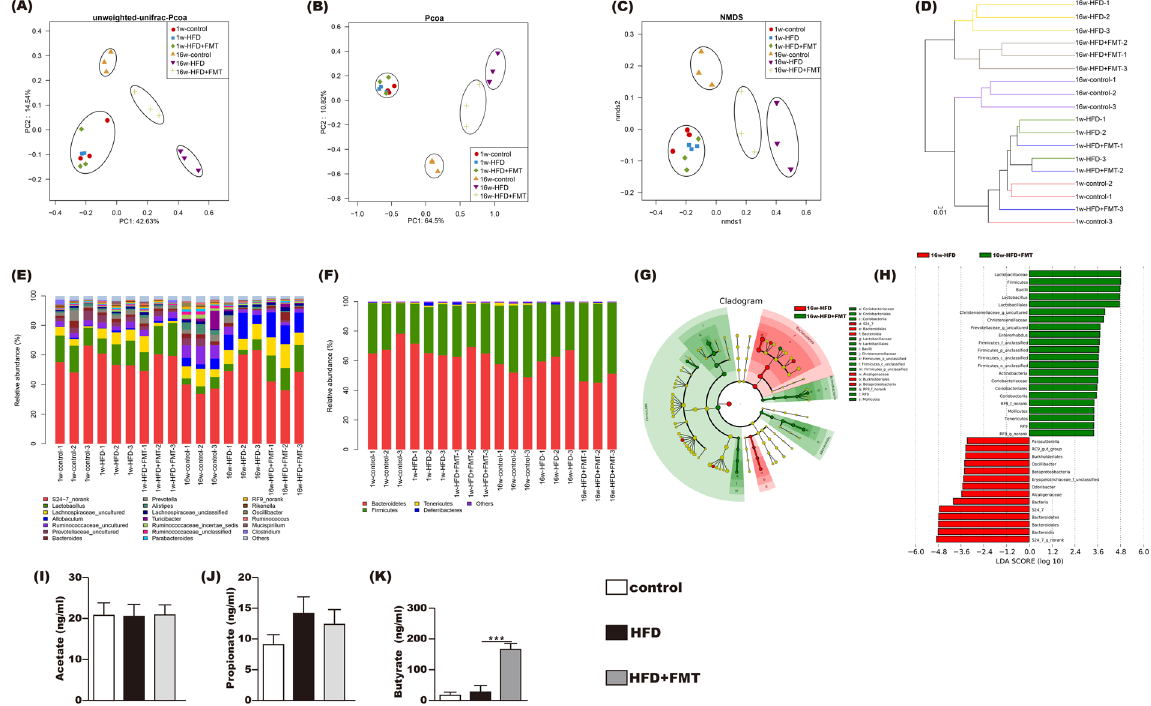
Figure 2. Influences of FMT on gut microbiota. ( A,B ) Scatter plot of the unweighted-unifrac-principal co- ordinates analysis (PCOA) score showing the similarity of the 18 bacterial communities based on the Unifrac distance and Scatter plot of the weighted-PCOA score. ( C ) Nonmetric multidimensional scaling (NMDS) showing the difference in bacterial communities according to the Bray-Curtis distance. (D) Hierarchical cluster analysis. ( E,F ) Bacterial composition of the different communities at the genus level ( E ) and at phylum level ( F ). Sequences that could not be classified into any known group were assigned as “no rank.” ( G,H ) Differences were represented in the color of the most abundant group. Key phylotypes of the gut microbiota responding to FMT treatment ( G ), the histogram ( H ) showing the lineages with LDA values as determined by LEfSe. ( I,K ) The acetic acid, propanoic acid and butyrate acid levels of the cecal content. The data represent the mean ± S.E.M. (n = 12 mice per group), *** P <